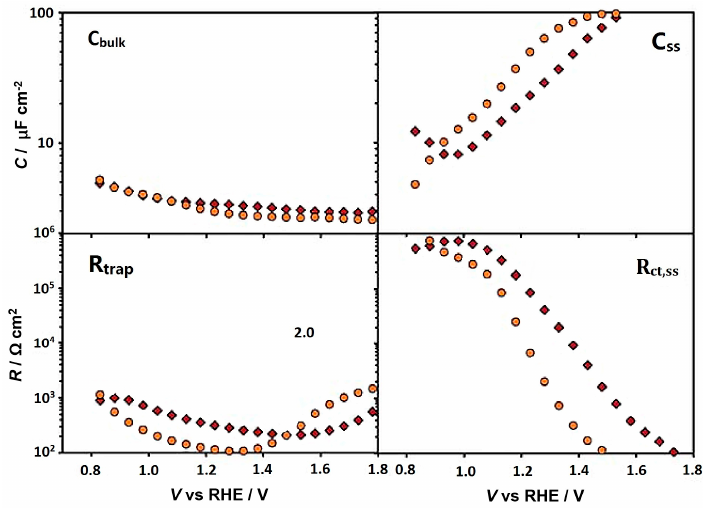
Figure 3. Impedance spectroscopy parameters calculated from fitting the EIS data to the equivalent circuit for an undoped (red diamonds) and a doped (orange circles) 300 cycle electrode. Adapted with permission from [41]. Copyright 2013 Royal Society of Chemistry.